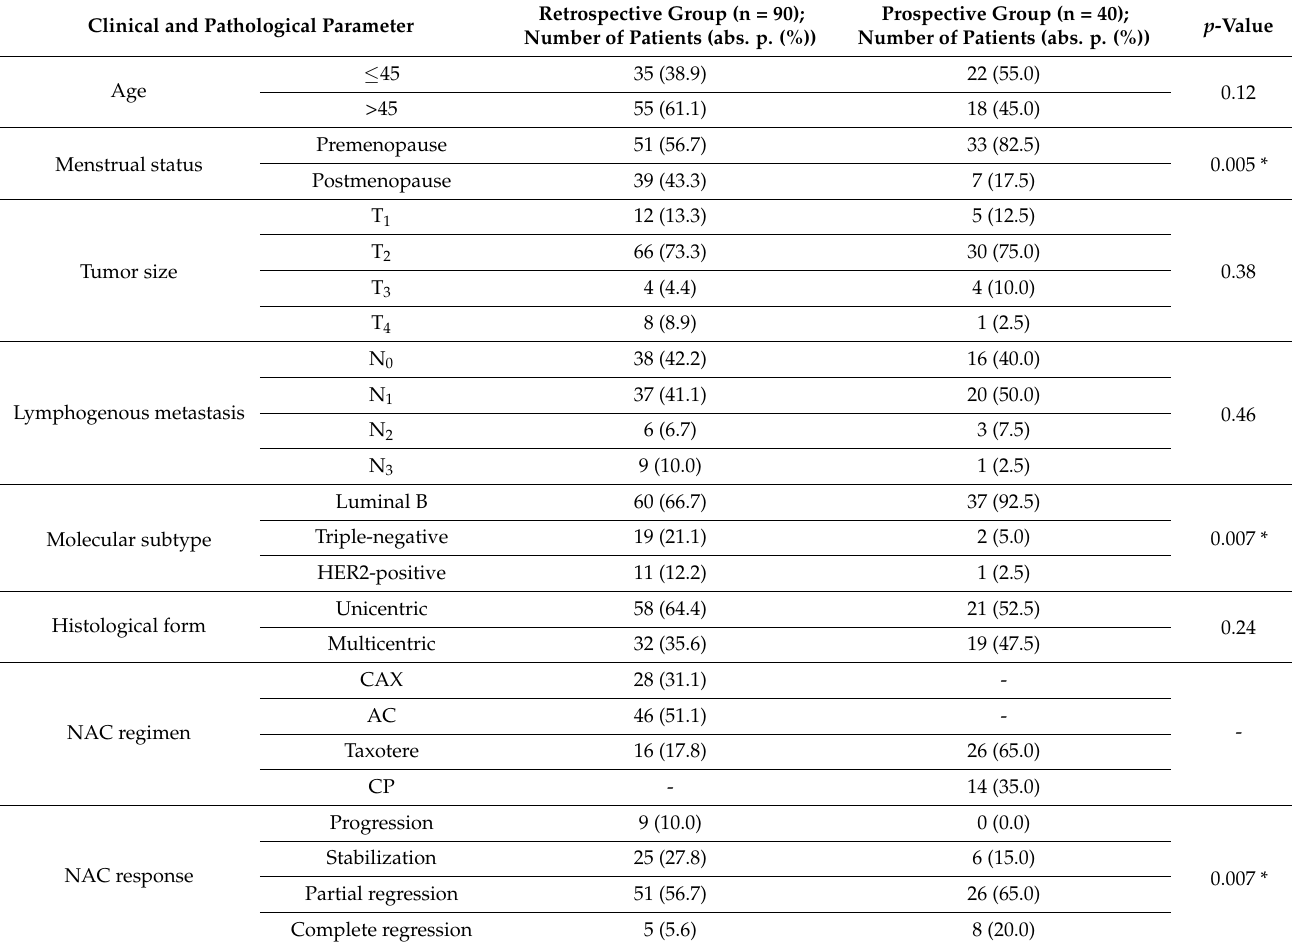
Table 1. Clinical and pathological characteristics of breast cancer